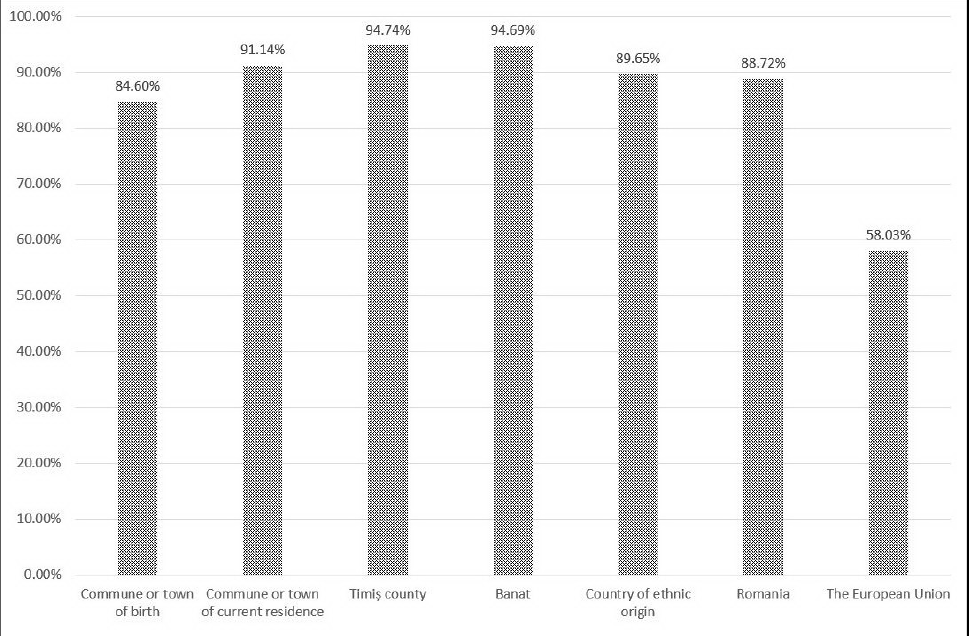
Figure 2. Degree of attachment of representatives of national minorities investigated in Timi ș County in 2020 to a range of territorial constructs (percentages of maximum score—based on social perception questionnaire).